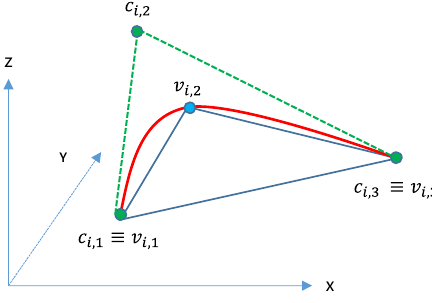
Figure 3. Example interpolating spline curve.